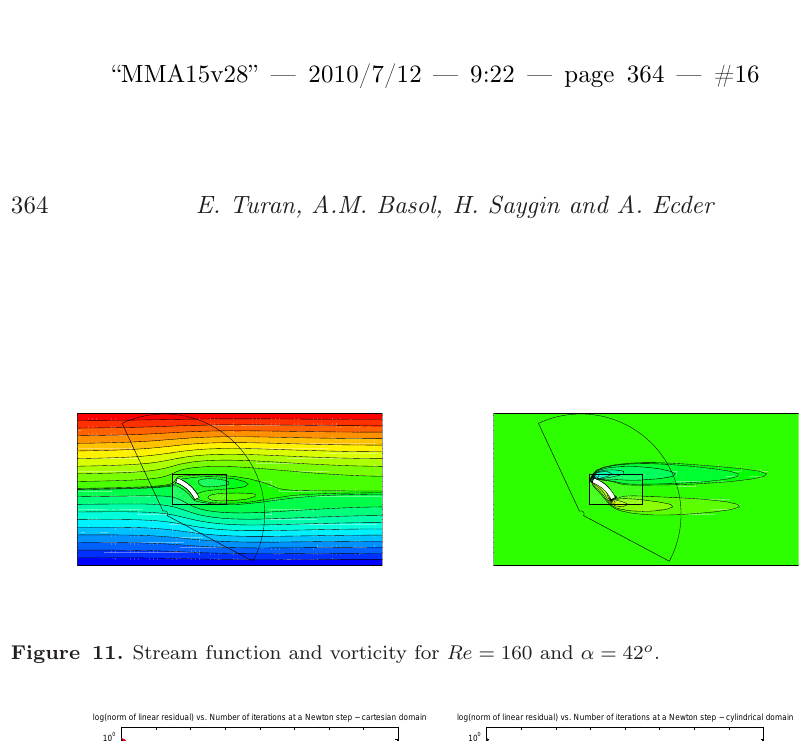
both forward and backward substitutions are needed in incomplete